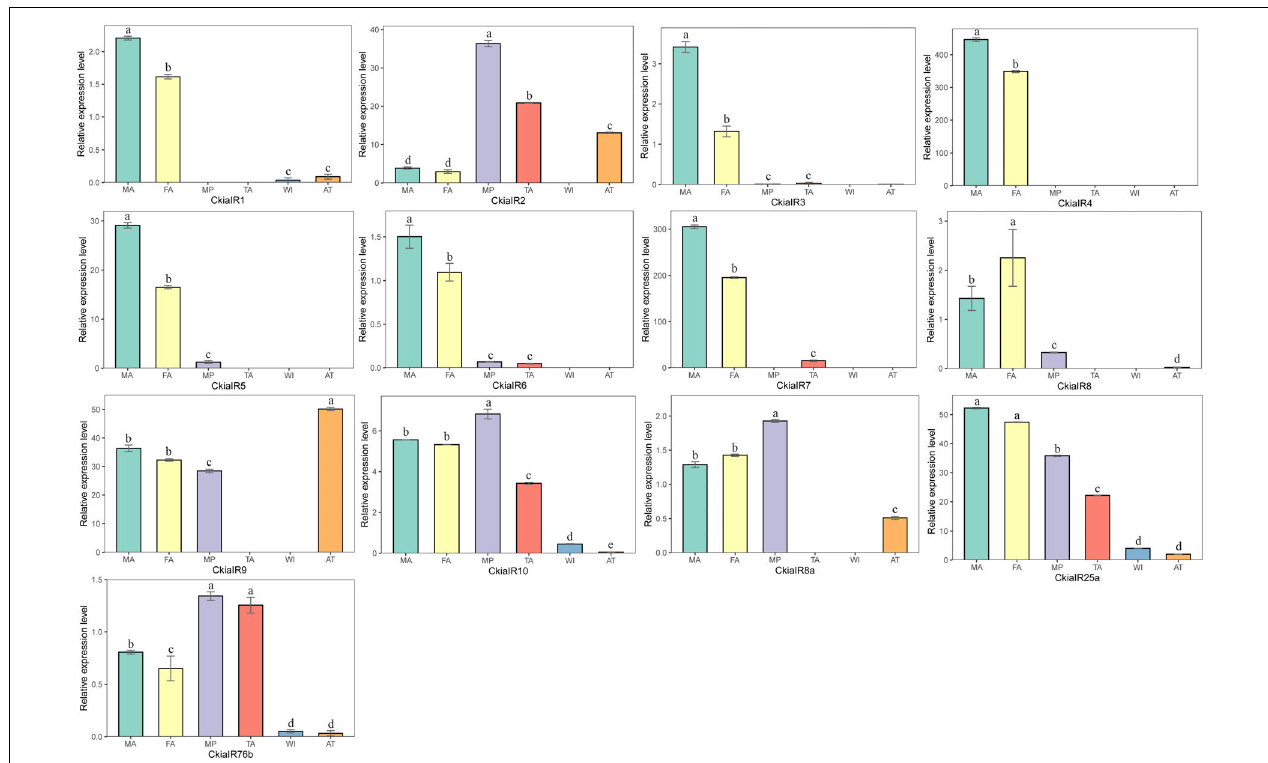
FIGURE 8 | Relative expression levels of IRs in different tissues of C. kiangsu as measured by RT-qPCR. FA, female antennae; MA, male antennae; MP, maxillary palps; TA, tarsi; WI, wings; AT, thoraxes-abdomens. The bar represents standard error and the different small letters above each bar indicate significant differences ( P <